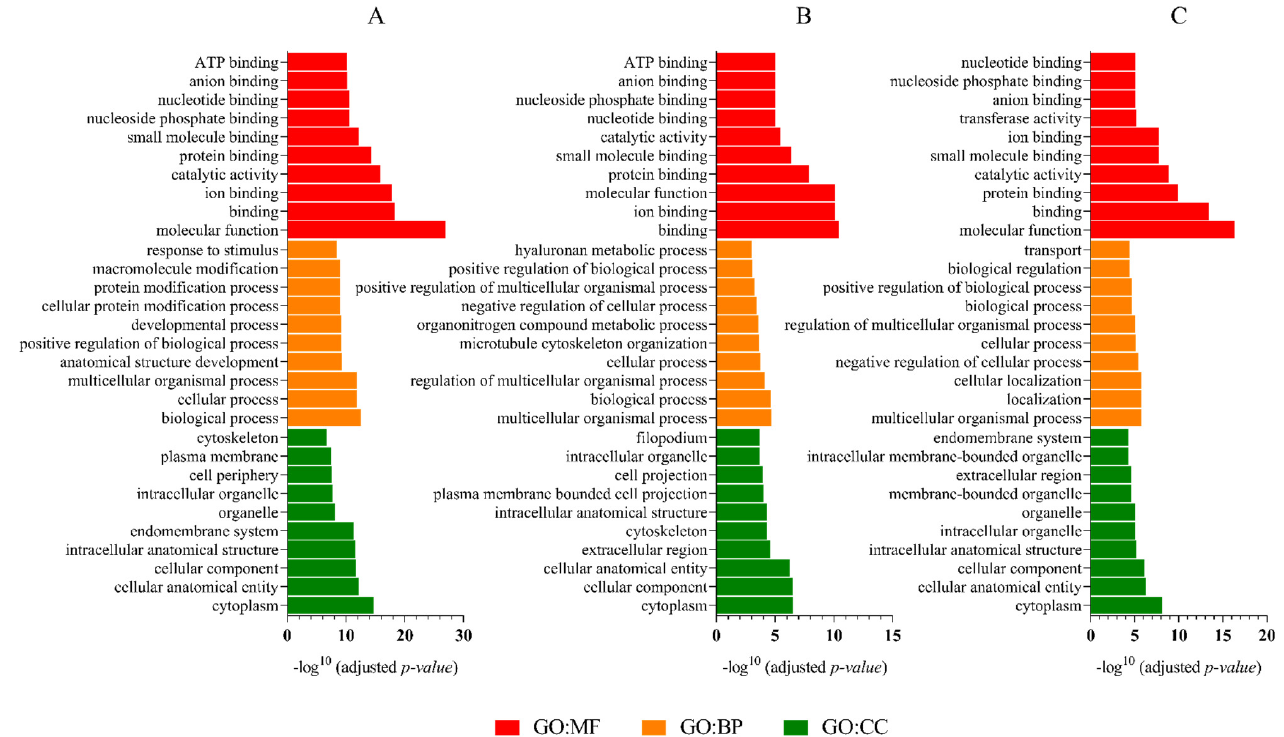
Figure 7. Gene Ontology (GO) of proteins that were present in the epididymal spermatozoa of dogs ( Canis lupus familiaris ) in different age groups: G1 ( A ), G2 ( B ), and G3 ( C ). There are ten highly significant GO terms for molecular function (GO:MF, red), biological process (GO:BP, orange), and cellular component (GO:CC, green) that are presented.